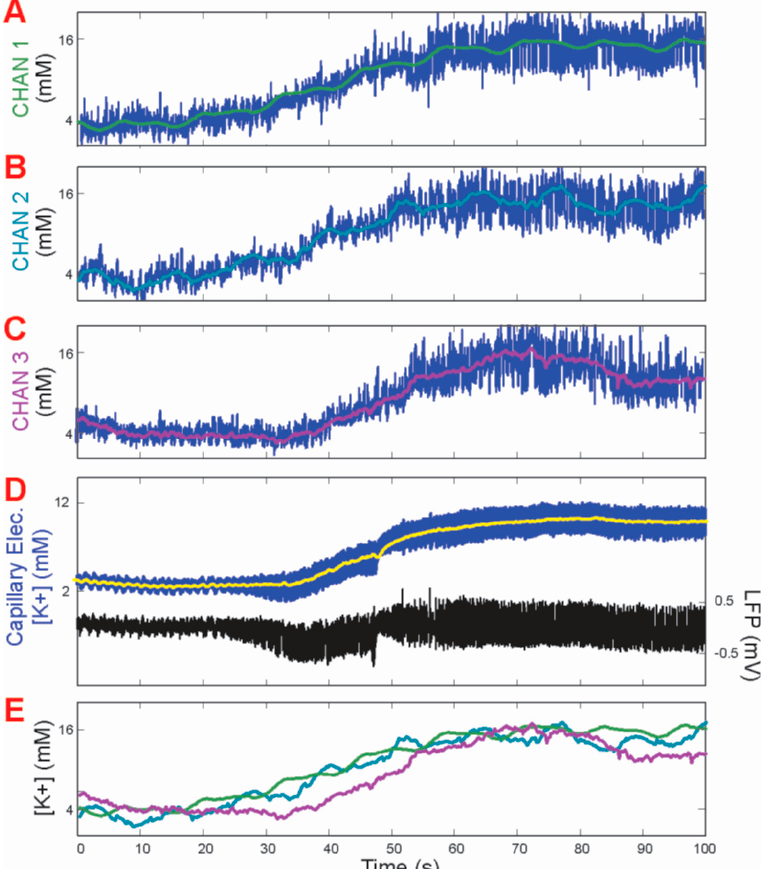
Figure 5. ( A – C ) At the onset of a 4-AP–induced focal neocortical seizure, [K + ] o measurements were shown using the coated gold microelectrodes for three individual channels as per Figure 5A–C with smoothed signals overlying the raw signal; ( D ) [K + ] o measurements for capillary electrode ( left axis) and electroencephalogram signal from reference electrode ( right axis); and ( E ) overlay of all three coated gold microelectrode channels with [K + ] o smoothed measurements, showing a delayed response in channel 3 which was apparently farthest from the seizure-onset zone, here demonstrating spatio-temporal specificity. Due to the plateau of the signal at each electrode, only the first 100 s of the 5 min measurement are displayed.